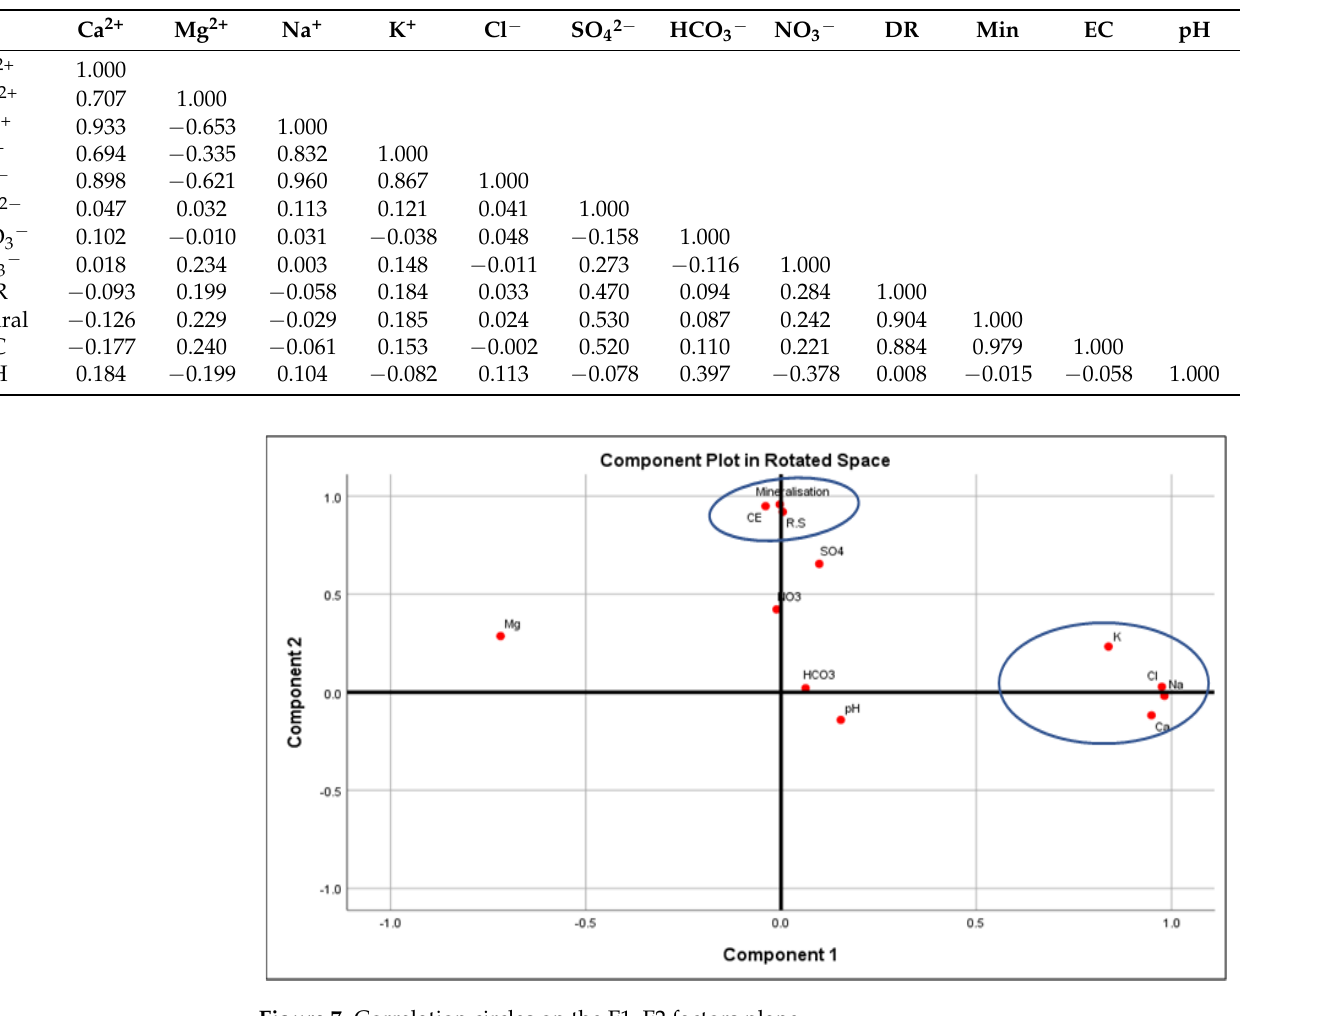
Figure 7. Correlation circles on the F1-F2 factors plane.